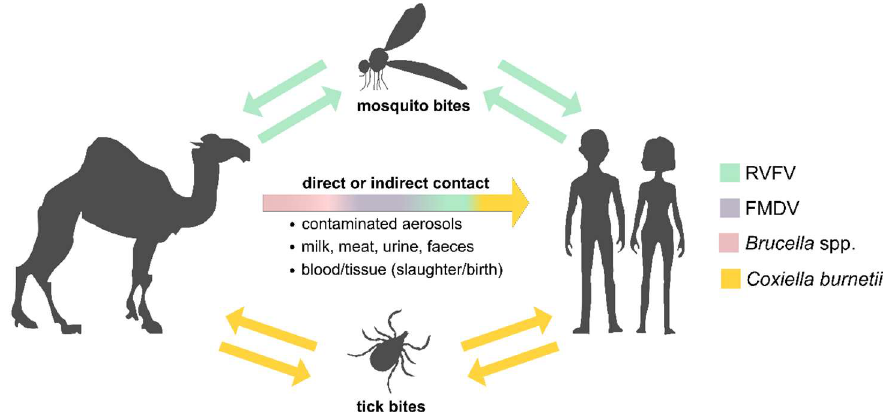
Figure 1. Schematic overview of pathogen transmission pathways. Rift Valley fever virus (RVFV, green), Foot-and-mouth disease virus (FMDV, purple), Brucella spp. (pink) and Coxiella burnetii (yellow) can be transmitted from dromedary camels both directly and indirectly. Furthermore, RVFV and C. burnetii can be transmitted by mosquitos and tick bites, respectively.